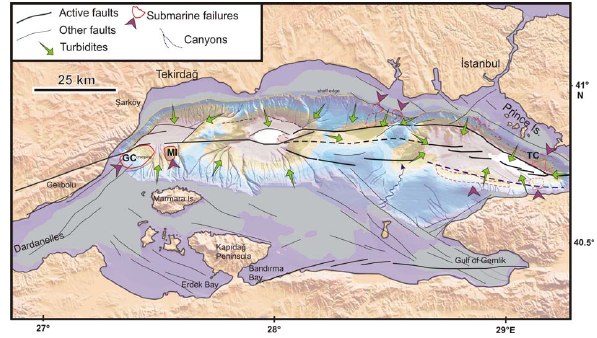
Fig. 2. Distribution of submarine canyons and scars of landslides superimposed on the shaded bathymetry of the Sea of Marmara which is drawn from the multibeam data seta of French institute IFREMER (Rangin et al., 2001) and Turkish Navy Department SHOD. The bathymetric data in the shelf is from navigation charts, so data grid is relatively scarce. Gridding and mapping of the data were obtained by means of Generic Mapping Tools (Wessel and Smith, 1998). Active fault traces are based on previous studies by Le Pichon et al. (2001) and Yaltırak (2002). Slides: GC (Ganos complex), MI (Marmara Island) and TC (Tuzla